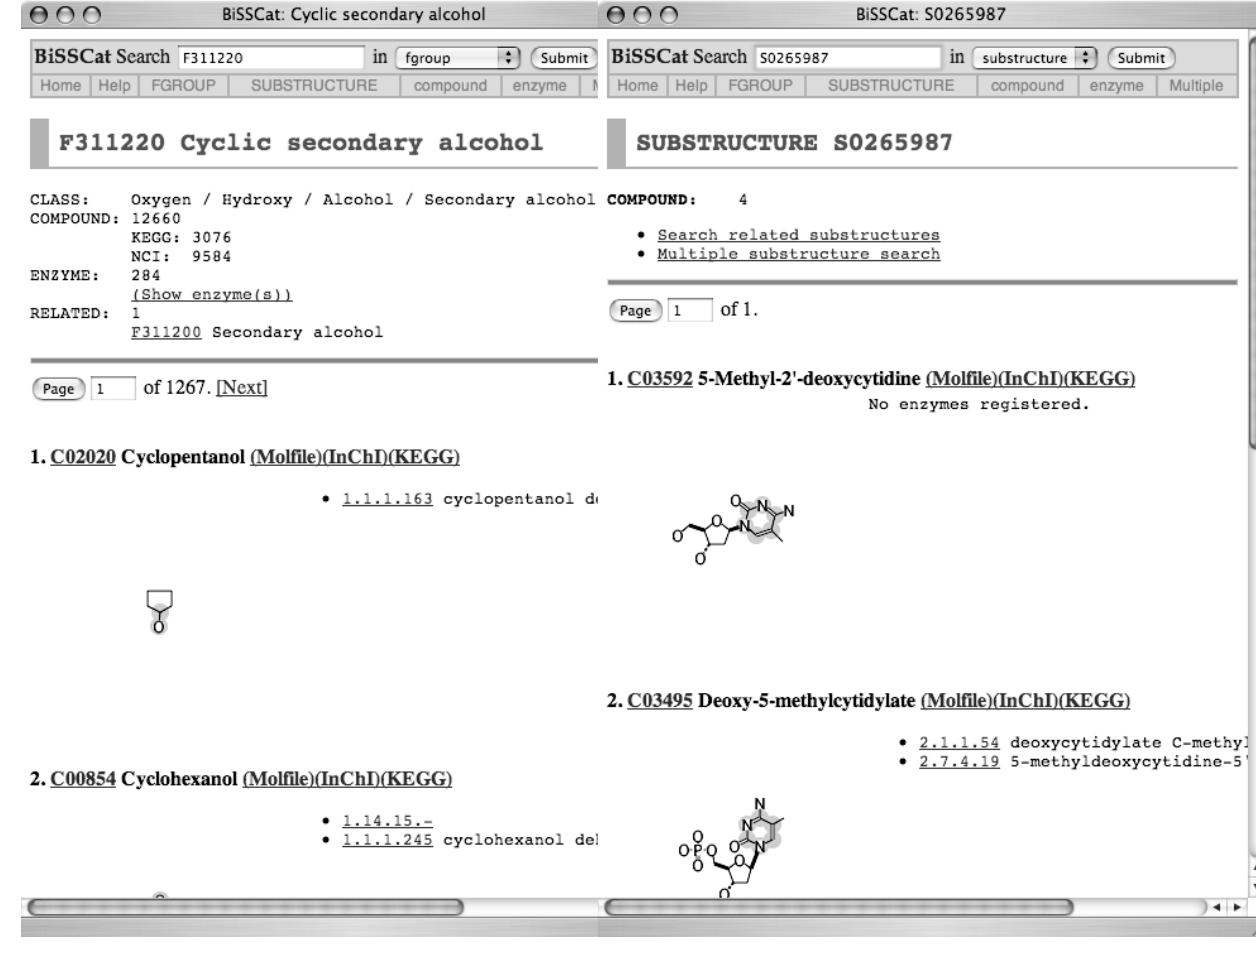
Figure 2. Screenshots of BiSSCat website: homepage (top), an example entry of FGROUP (left) and of SUBSTRUCTURE (right).